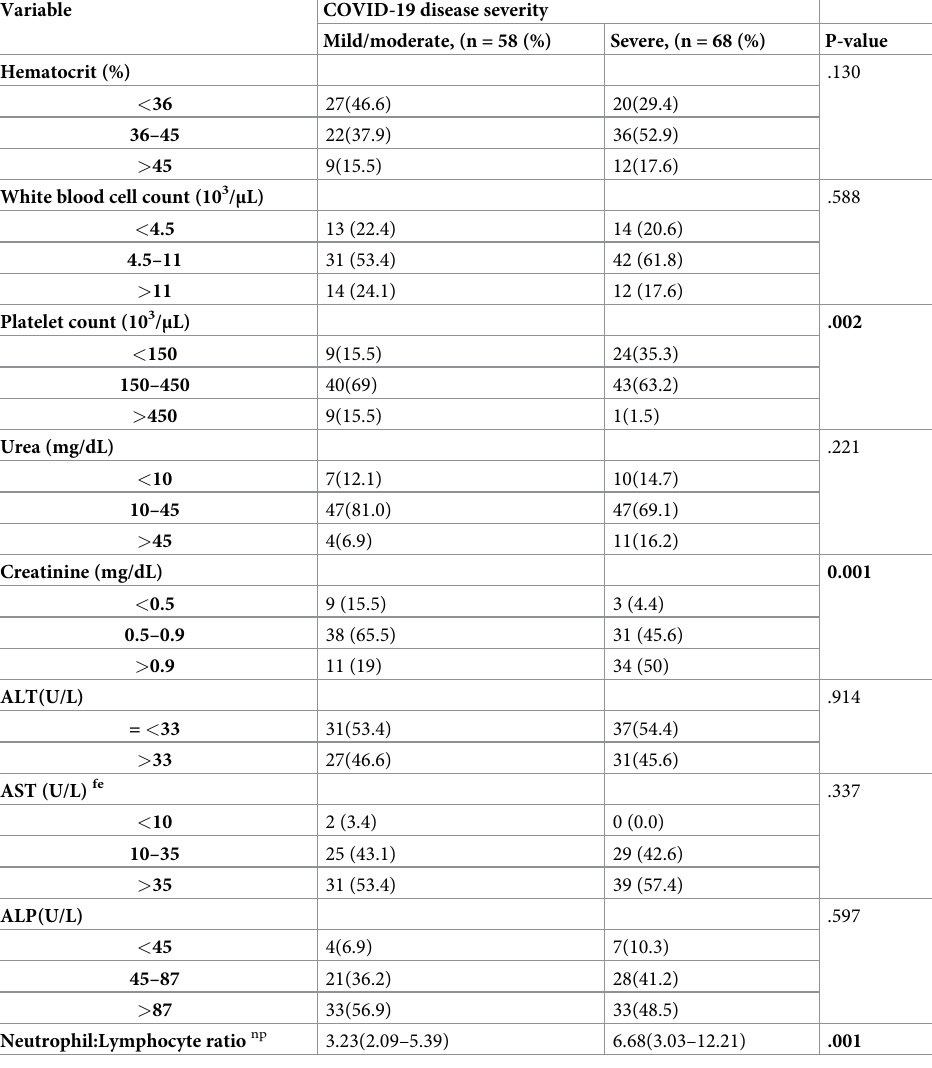
Table 2. Laboratory biomarker-related variables by COVID severity classification (n =